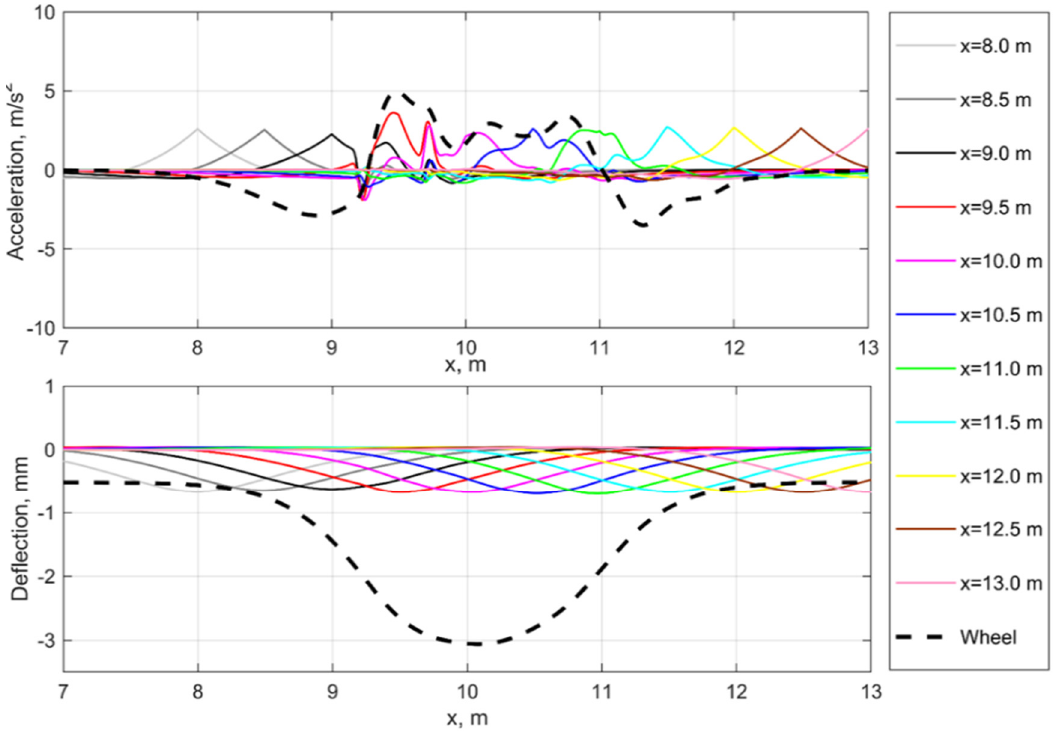
Figure 6. Simulated rail and wheel acceleration ( top ) and deflections ( bottom ) for the equivalent to void geometrical ir- regularity.